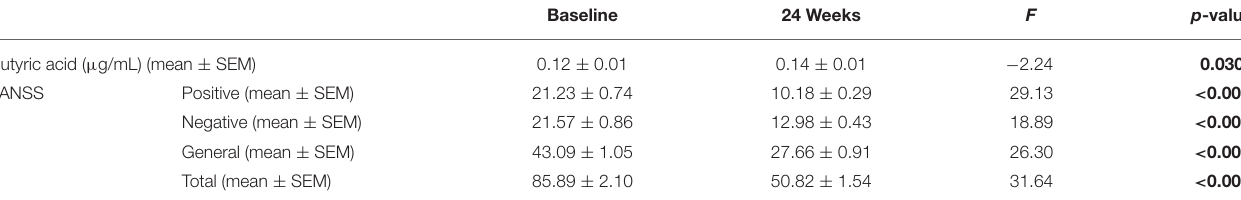
TABLE 2 | The serum levels of butyric acid and PANSS total and subscale scores in patients at baseline and 24 weeks after treatment.